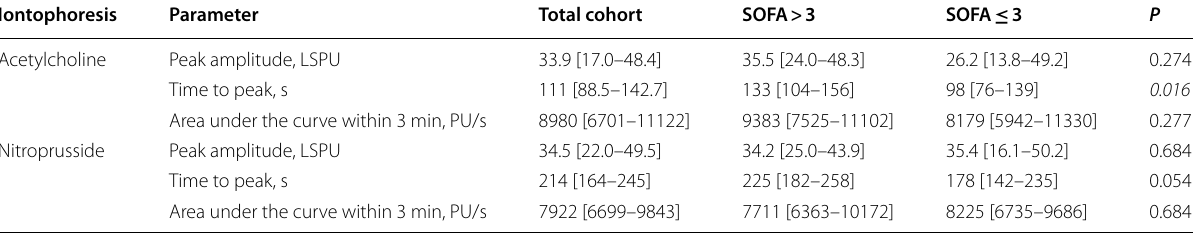
Table 2 Association between iontophoresis results and a SOFA score > 3 at 48 h